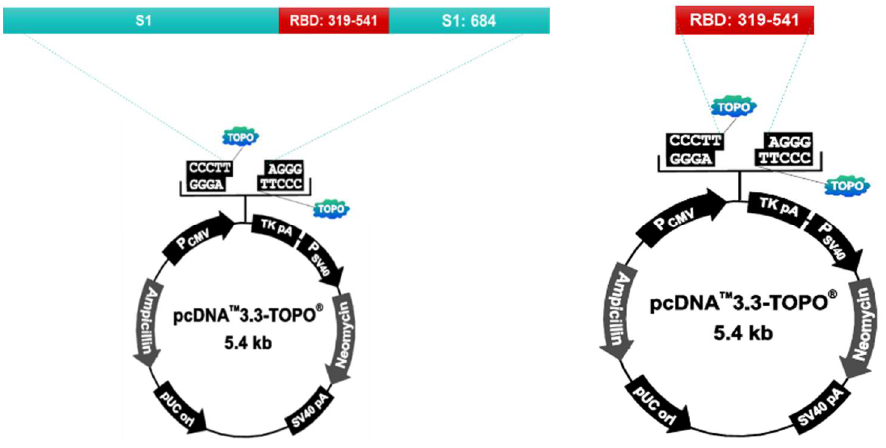
Figure 1. S1 protein and RBD protein recombinant plasmids were prepared using the pcDNA™3.3- TOPO ® vector (ThermoFisher, Waltham, MA. United States. Cat No. K8300-01). Chinese Hamster Ovary(CHO) cells were used for protein expression. After culturing the transformed CHO cells, the supernatant is collected, filtered, and puri-fied by column loading (GE healthcare, AKTA prime plus).